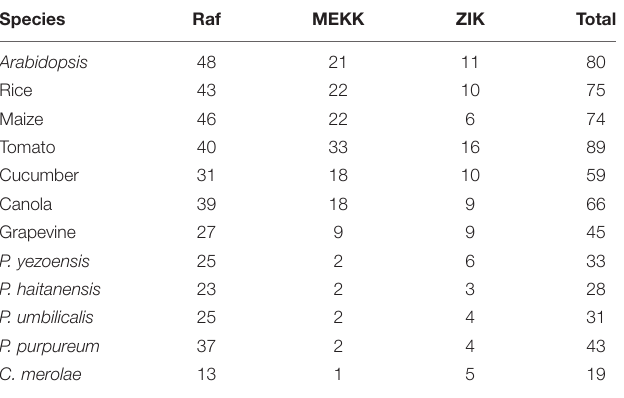
TABLE 2 | Comparison of the gene abundance in three subfamilies of MAPKKK genes in different plants and red algae. Species Raf MEKK